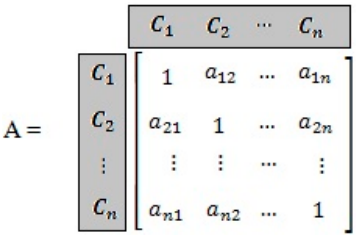
Figure 5. Pairwise Comparison Matrix.